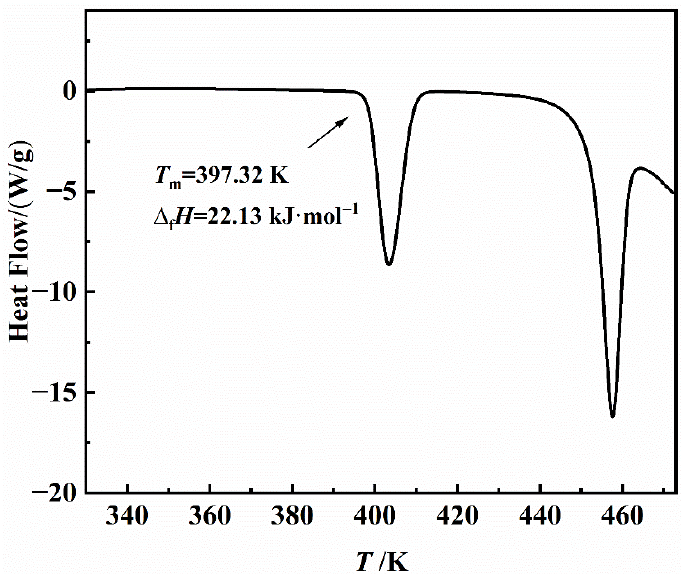
Figure 5. DSC of 1,5-pentanediamine adipate dihydrate after dehydration.